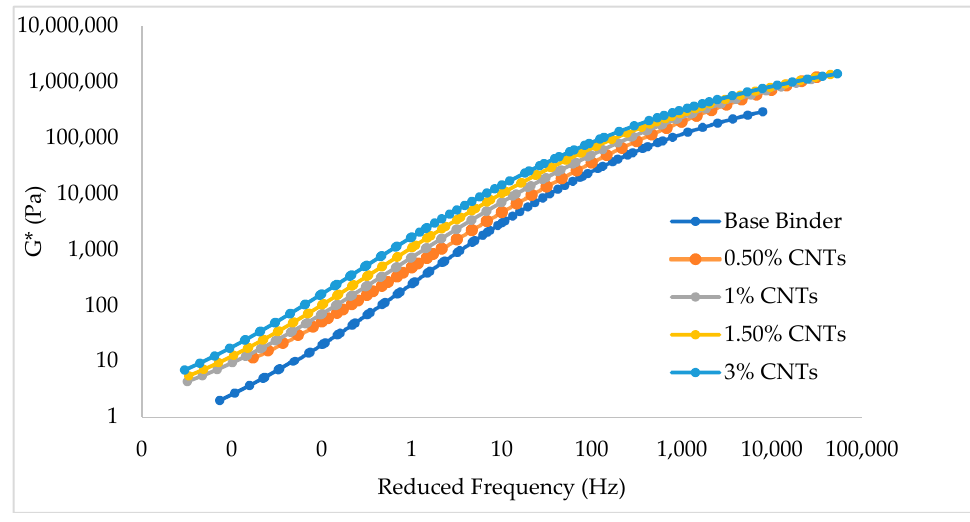
Figure 12. Master curve of G* for CNT-modified and unmodified bitumen at 58 °C.